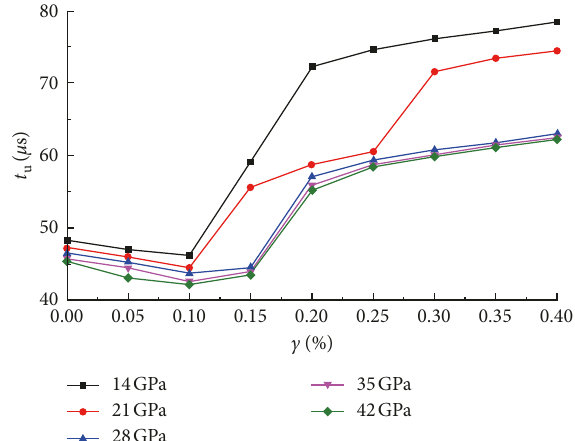
Figure 10: Relation between stress equilibrium time t surface nonparallelism c